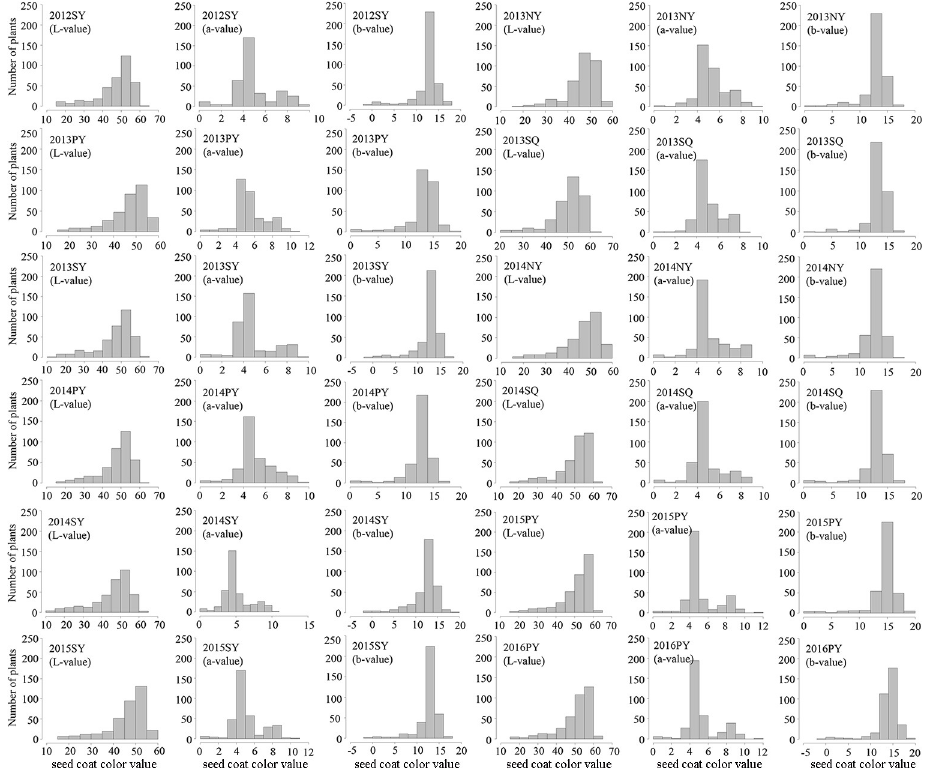
Fig 1. Histograms for the frequency distribution of three color space values (L-value, a-value and b-value).